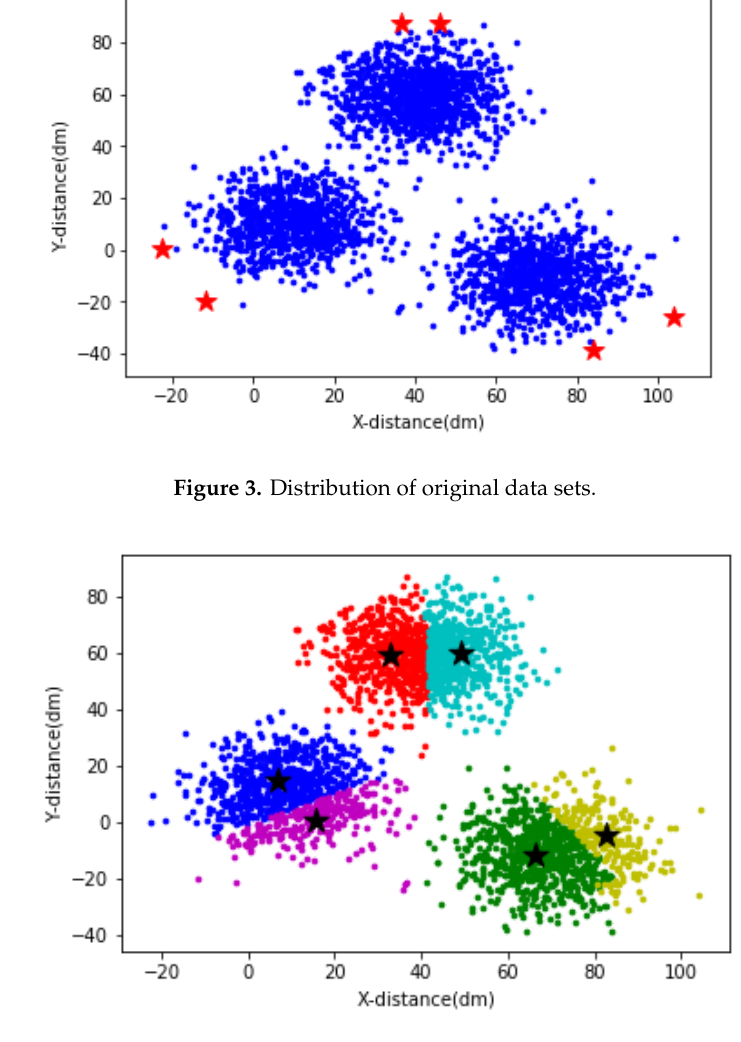
Figure 5. Performance comparisons of clustering algorithms on precision. 4.2. Effects of  ,  and Density on Service Recommendation